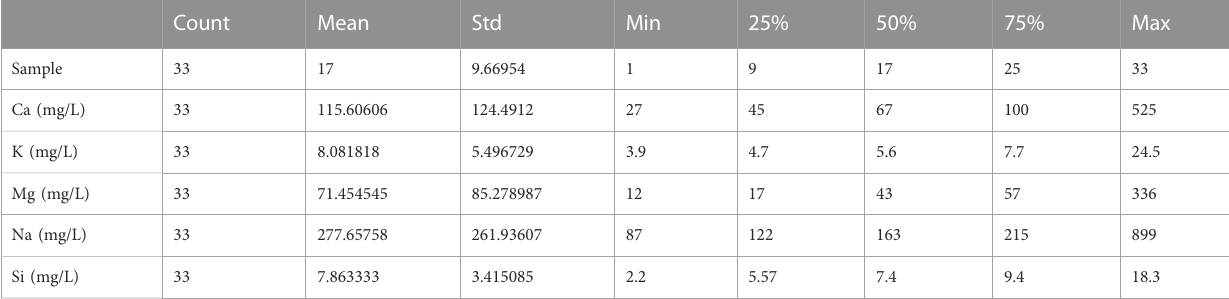
TABLE 6 Statistical analysis of major elements of water sample in Rahat Volcanic